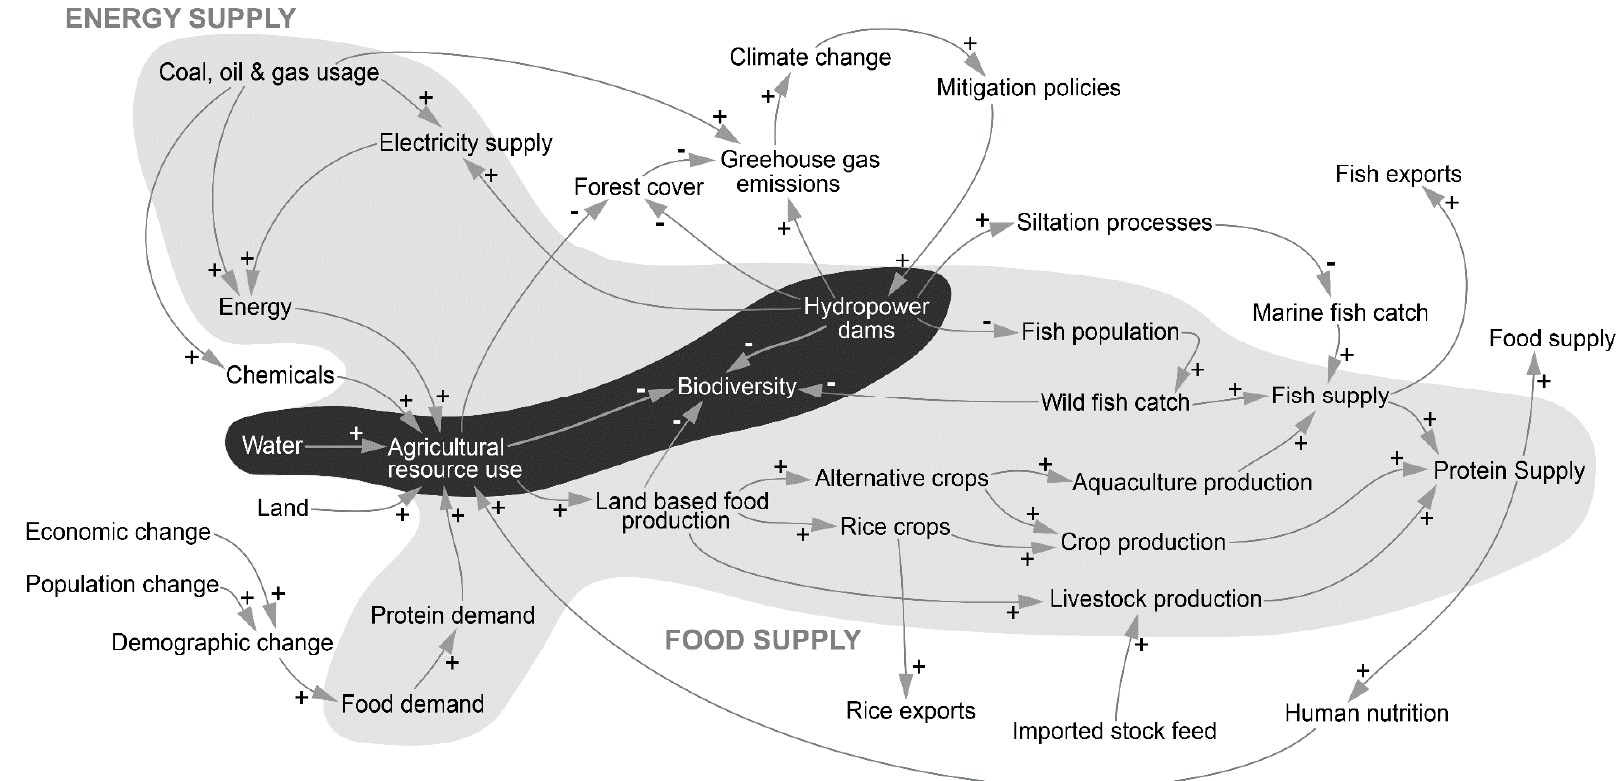
Figure 8. Elaborate influence model for the hydropower–food supply nexus in the lower Mekong Basin. The shaded food supply loop on the right is drawn from Figure 5, whereas the energy loop on the left is based on Figure 6. The darker shaded overlap between these two loops highlights that water, agricultural resources use, biodiversity and hydropower dams are the nexus in this system.